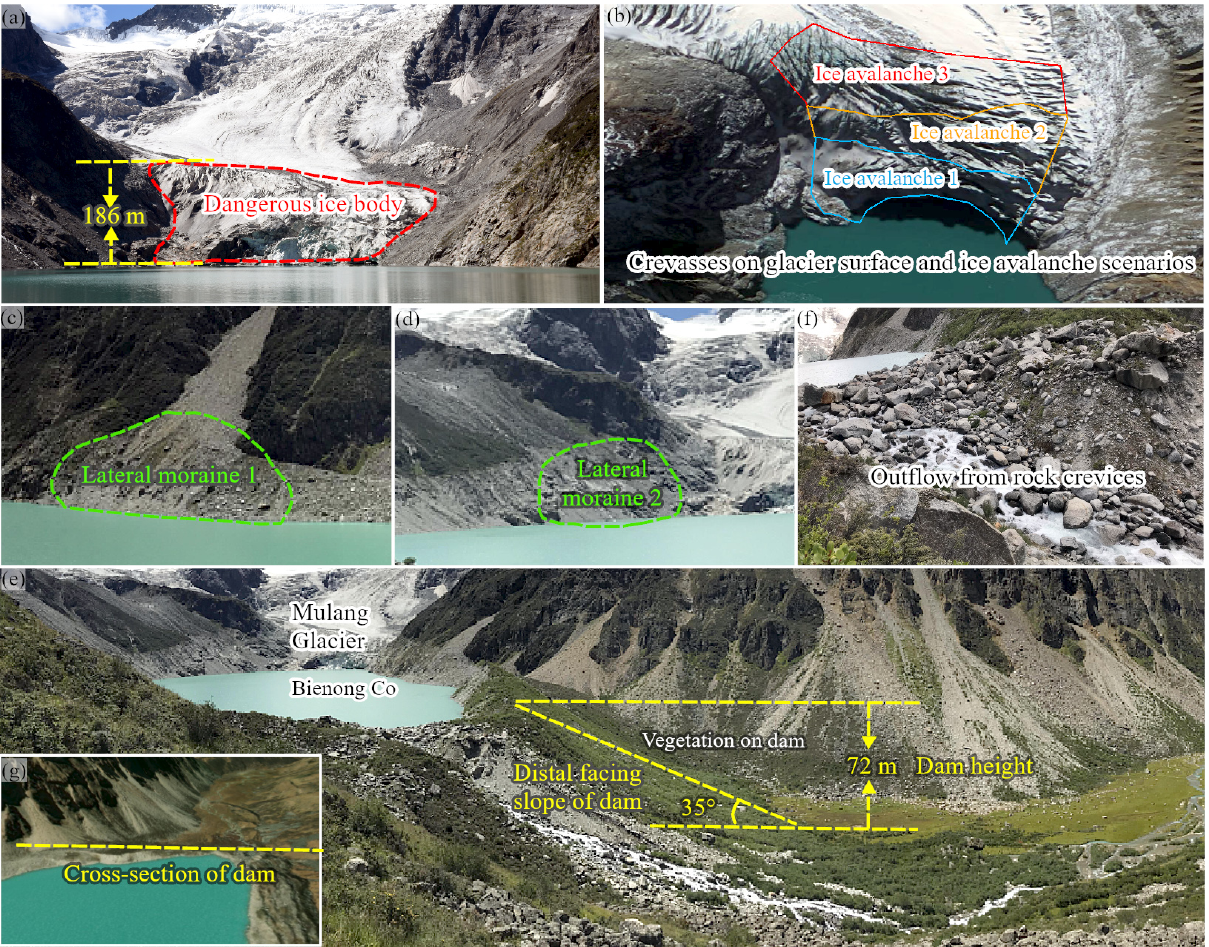
Figure 2. The hazard assessment of Bienong Co. (a) The connection condition of Mulang Glacier and Bienong Co, (b) the crevasses on the glacier surface and the assumed ice avalanche scenarios of Mulang Glacier, (c) and (d) the assumed lateral moraine location, (e) and (f) the moraine dam of Bienong Co, and (g) a cross-section of the moraine dam for statistical purposes. Panels (b) and (g) are based on a MapWorld image, while the other photographs were taken by Xiaojun Yao and Qi Wang on 27 August